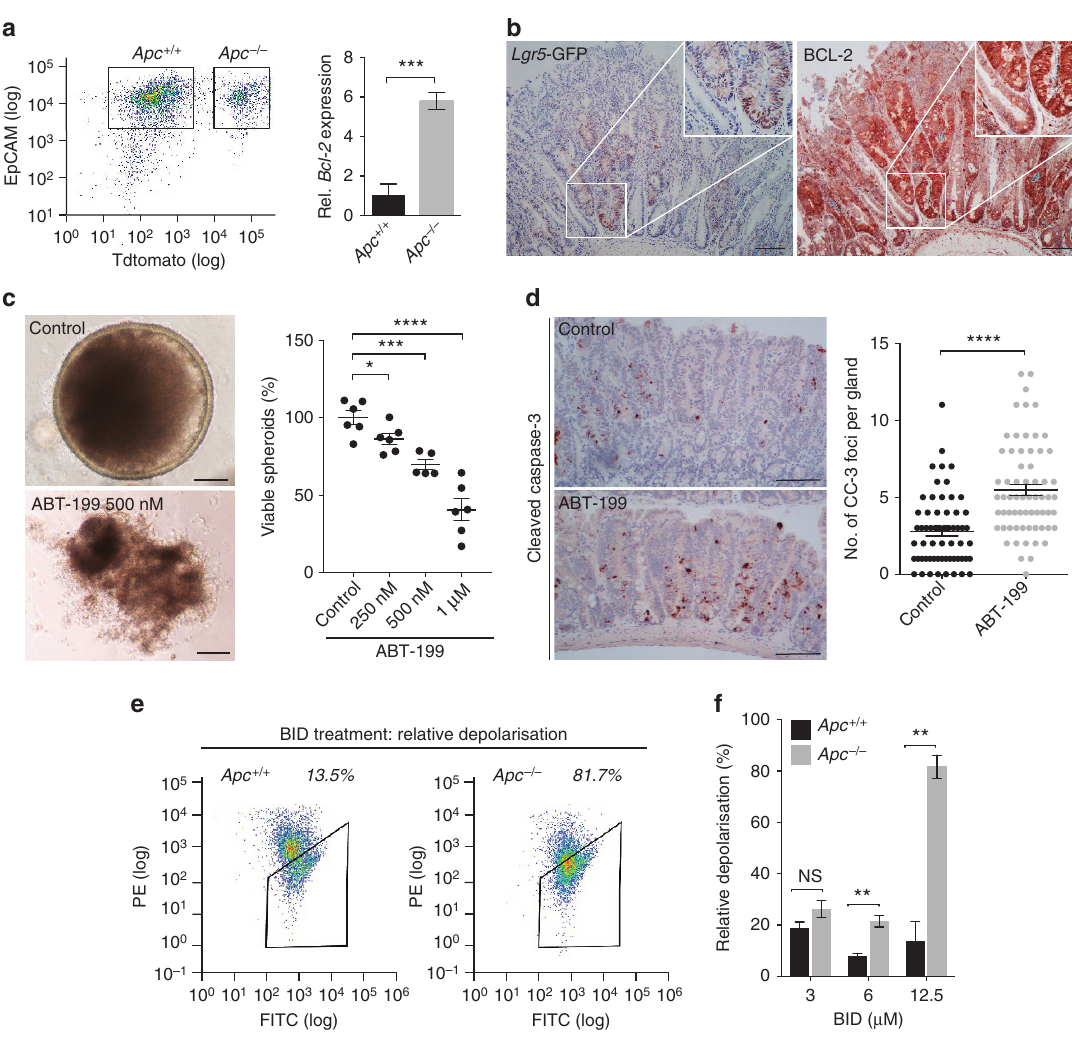
Figure 6 | BCL-2 inhibition causes cells to undergo apoptosis in established adenomas. ( a ) Isolation of Apc þ / þ and Apc (cid:2) / (cid:2) cells at day 14 post low-level clone induction in AhCre ER . Apc fl/fl . Lox-STOP-Lox - tdTomato þ / (cid:2) mice. The left panel represents the FACS sort analysis and the graph shows the relative Bcl-2 expression of the Apc þ / þ compared with the Apc (cid:2) / (cid:2) cell population. Error bars represent s.d. ( n ¼ 3 per condition), *** P o 0.001, Student’s t -test. ( b ) Lgr5 -GFP and BCL-2 stained adenomas in a Lgr5 . Apc fl/fl mouse 5 weeks post induction demonstrating overexpression of Bcl-2 in the Lgr5 -GFP þ adenomatous glandular structures. Scale bars, 100 m m. ( c ) Representative images of Apc -deficient spheroids; upper image showing a viable spheroid of the control group and the lower image demonstrating a non-viable spheroid as observed after ABT-199 treatment. The graph displays the amount of viable spheroids counted at 72h after the start of ABT-199 treatment for the indicated doses. Scale bars, 50 m M. Dots indicate replicates (minimal n ¼ 5 per condition), error bars represent the s.e.m. * P o 0.05, *** P o 0.001, **** P o 0.0001, Student’s t -test. ( d ) Lgr5.Apc fl/fl mice with established adenomas 4 weeks following induction were treated with ABT-199 for 4 consecutive days. Cell death within these adenomas was compared with cell death within adenomas of untreated Lgr5.Apc fl/fl mice by counting the amount of cleaved caspase-3 (CC-3) positive foci for each glandular structure. Each dot represents a gland (minimal n ¼ 62 glands per condition), error bars indicate the s.e.m. **** P o 0.0001, Student’s t -test. ( e ) FACS graphs indicating the sorting gates for Ah Cre ER . Apc þ / þ and Ah Cre ER . Apc (cid:2) / (cid:2) cells that have lost a JC-1 signal. ( f ) Bar graph showing the percentage of cells undergoing mitochondrial depolarization for the indicated concentrations of the BID peptide. The percentage of cells undergoing mitochondrial depolarization was measured with JC-1 staining and was calculated relative to the negative (DMSO) and positive (CCCP)